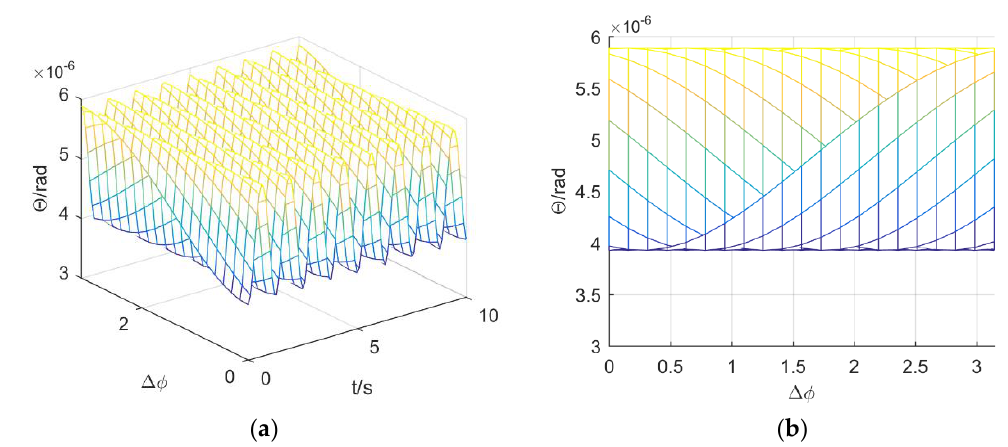
Figure 11. Given α = 5, ∆ ω = 5, the influence of phase difference on the peak value of output light angle response: ( a ) The amplitude variation of output light angle response under phase difference, and time variable; ( b ) the amplitude variation of angular response of phase difference output light.